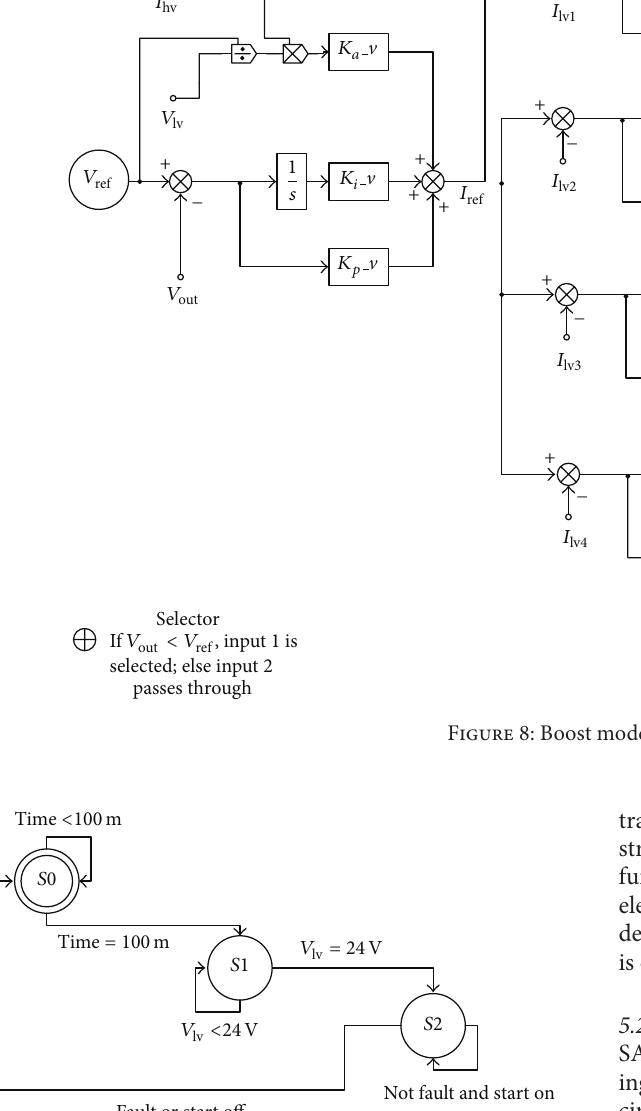
Figure 9: Buck mode state